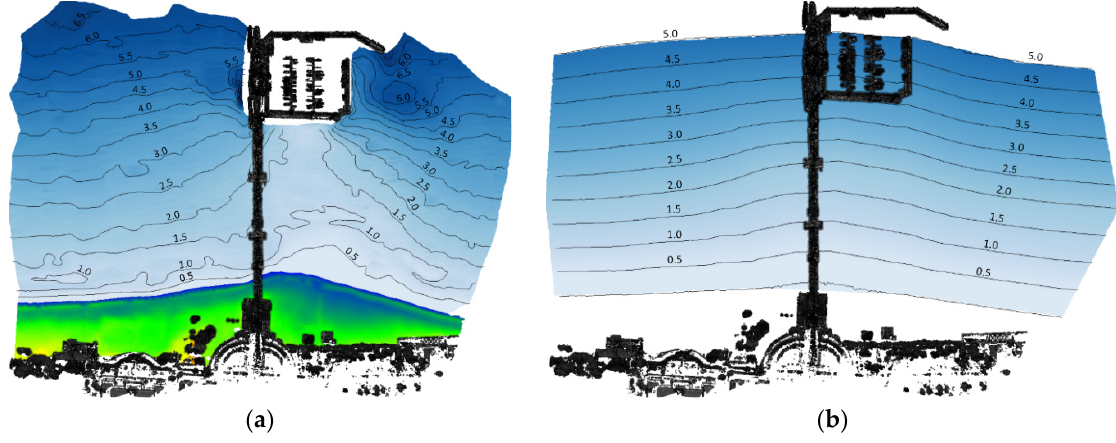
Figure 15. Bathymetric chart of the tombolo phenomenon in Sopot ( a ) and a bathymetric map based on data from the 2011 electronic navigational chart (ENC) ( b ).